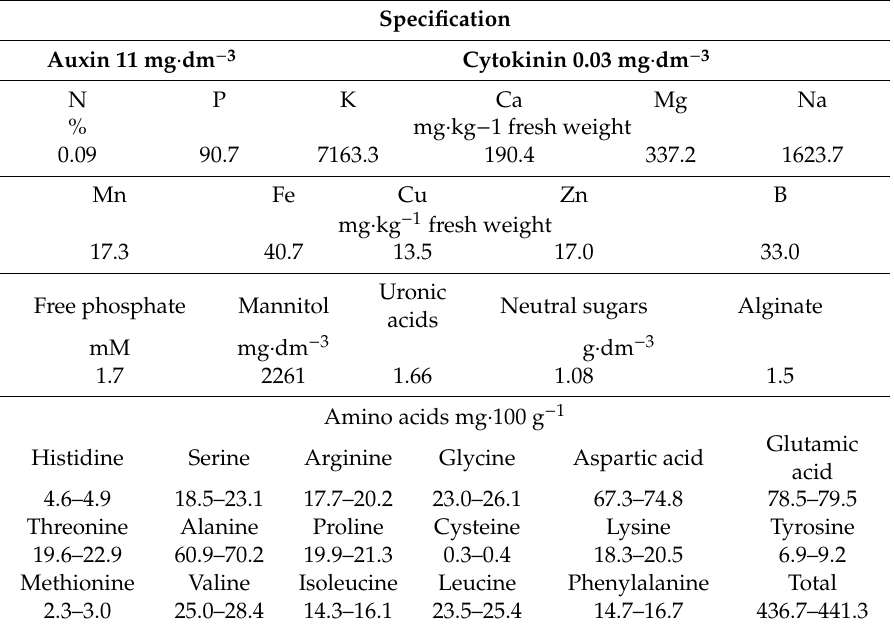
Table 2. Composition of the biostimulant